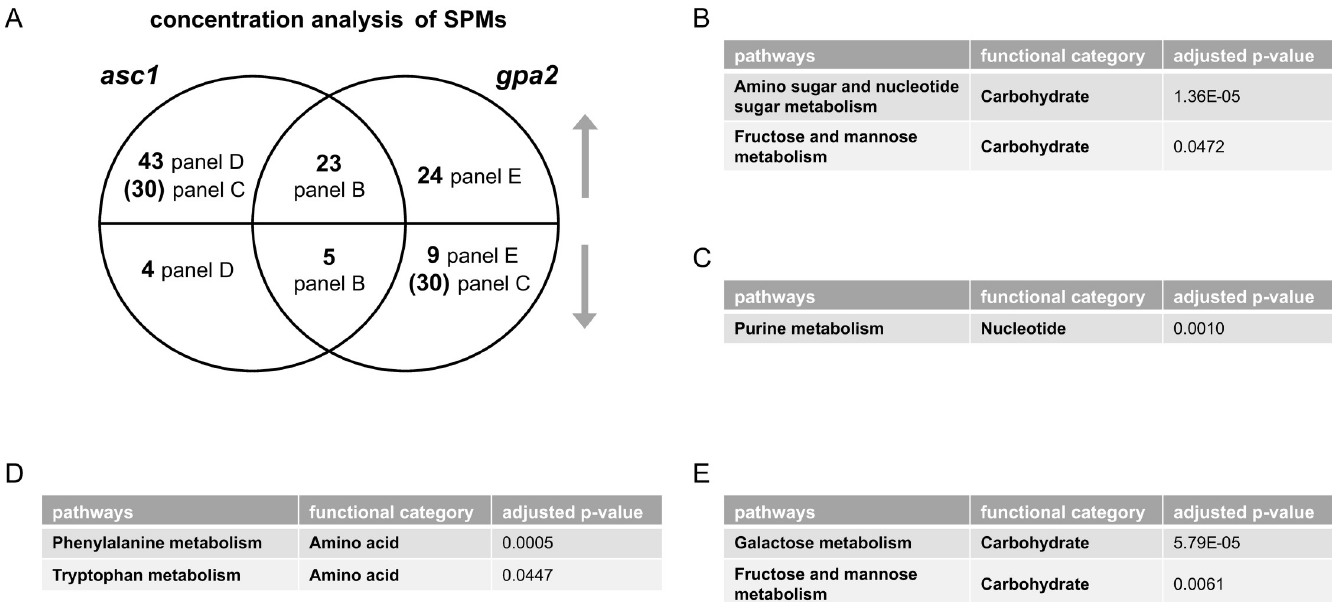
Fig 3. Concentration analysis of significantly perturbed metabolites (SPMs) after glucose addition. A) Venn diagram of subsets of SPMs, for asc1 and gpa2 vs. wildtype, after glucose addition. Upper semicircle shows up-regulated SPMs and lower semicircle shows down-regulated SPMs. Numbers in parenthesis are shared SPMs regulated in the opposite direction, placed in the area corresponding to the direction of regulation. SPMs used for ORA analysis that are B) shared and change in the same direction; C) shared and change in the opposite direction; D) unique to asc1 ; E) unique to gpa2 . Listed are all pathways and their functional categories with adjusted p-value <